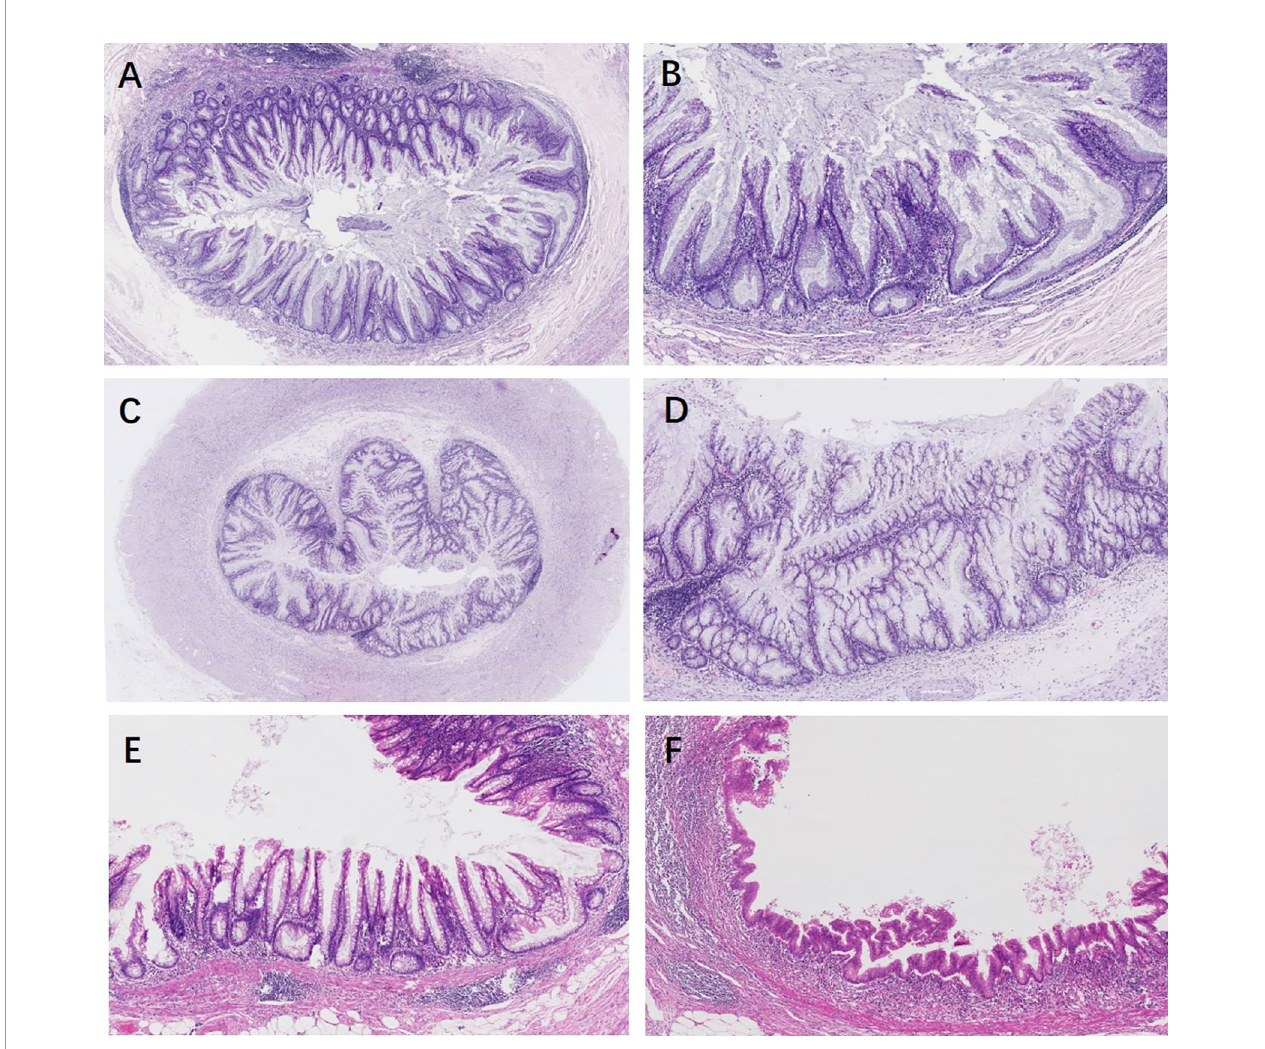
FIGURE 2 | Appendiceal serrated lesions. (A, B) Serrated lesions without dysplasia. (A) Serrated lesions without dysplasia involve a portion of the appendiceal circumference. (B) On higher power, serration and dilation extend to the crypt bases with abnormal L shapes. (C – F) Serrated lesions with dysplasia. (C) Serrated lesions with dysplasia involve the entire appendiceal circumference. (D) On higher power, the dysplasia is low grade, resembling traditional serrated adenoma-like dysplasia. Multiple ectopic crypt formations and villous growth are noted. (E) A typical appendiceal serrated lesion with focal area of fl attened or scalloped monolayer of epithelium mimic a low-grade appendiceal neoplasm, but maintained an intact lamina propria and muscularis mucosae (F)